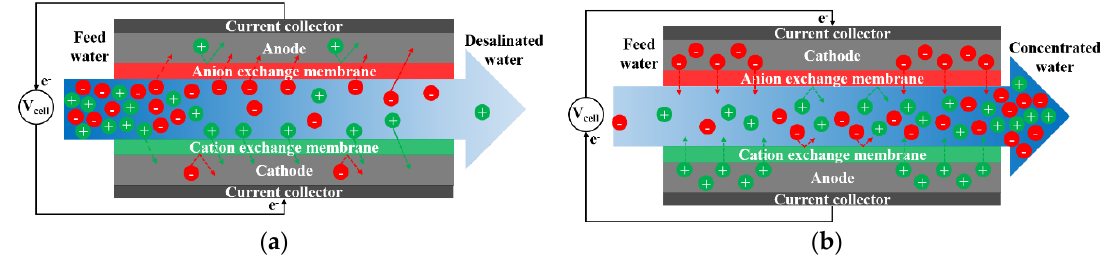
Figure 1. Schematic diagrams of MCDI, ( a ) desalination process, ( b ) regeneration process.